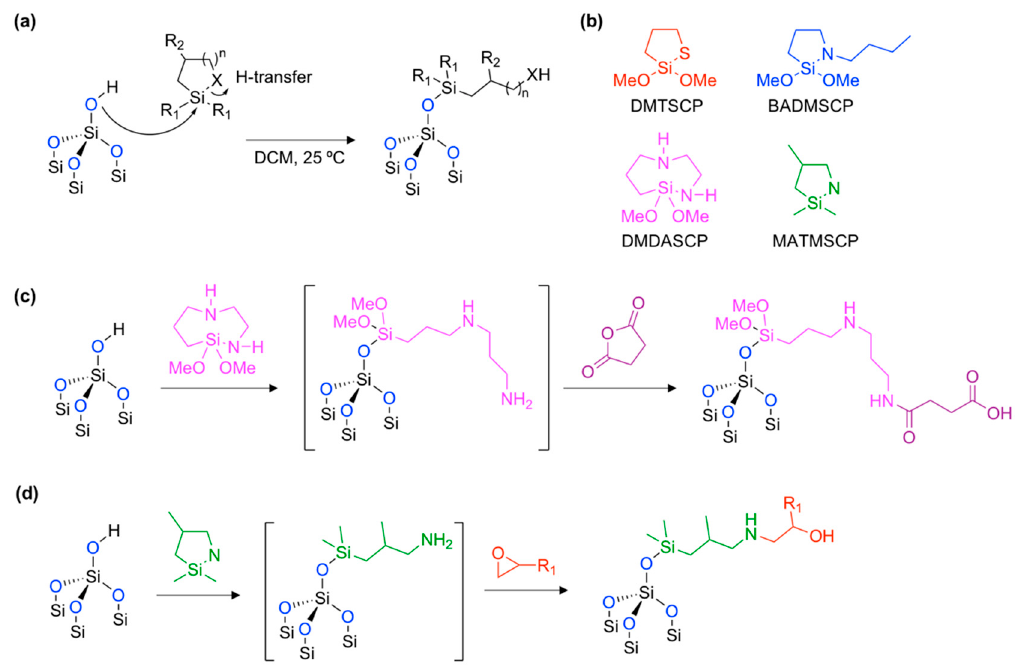
Figure 7. Ring-opening click chemistry of oxidized pSi surface (Si–OH) with cyclic-silane reagent. ( a ) Reaction mechanism. DCM: dicholoromethane. R 1 = OMe, Me. R 2 = H, Me. X = S, N. ( b ) Cyclic-silane reagents. ( c , d ) Further functionalization of ring-opening click chemistry products (pink and olive) via amide coupling with succinic anhydride (purple) and tandem coupling with epoxy containing reagent (red). DMTSCP: 2,2-dimethoxy-1-thia-2-silacyclopentane. BADMSCP: N - n -butyl-aza-2,2-dimethoxy-silacyclopentane. DMDASCP: 2,2-dimethoxy-1,6-diaza-2-silacyclooctane. MATMSCP: N-methyl-aza-2,2,4-trimethyl-silacyclopentane.